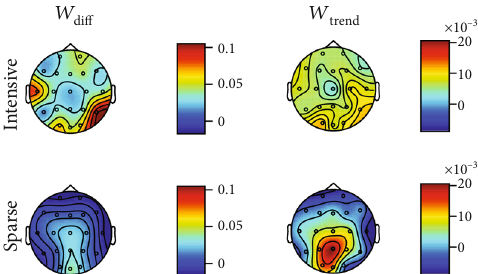
Figure 5: Topographic distribution of median of W (equation (5)) measures for the INTENSIVE and (4)) and W trend SPARSE groups within session for the upper alpha (UA)